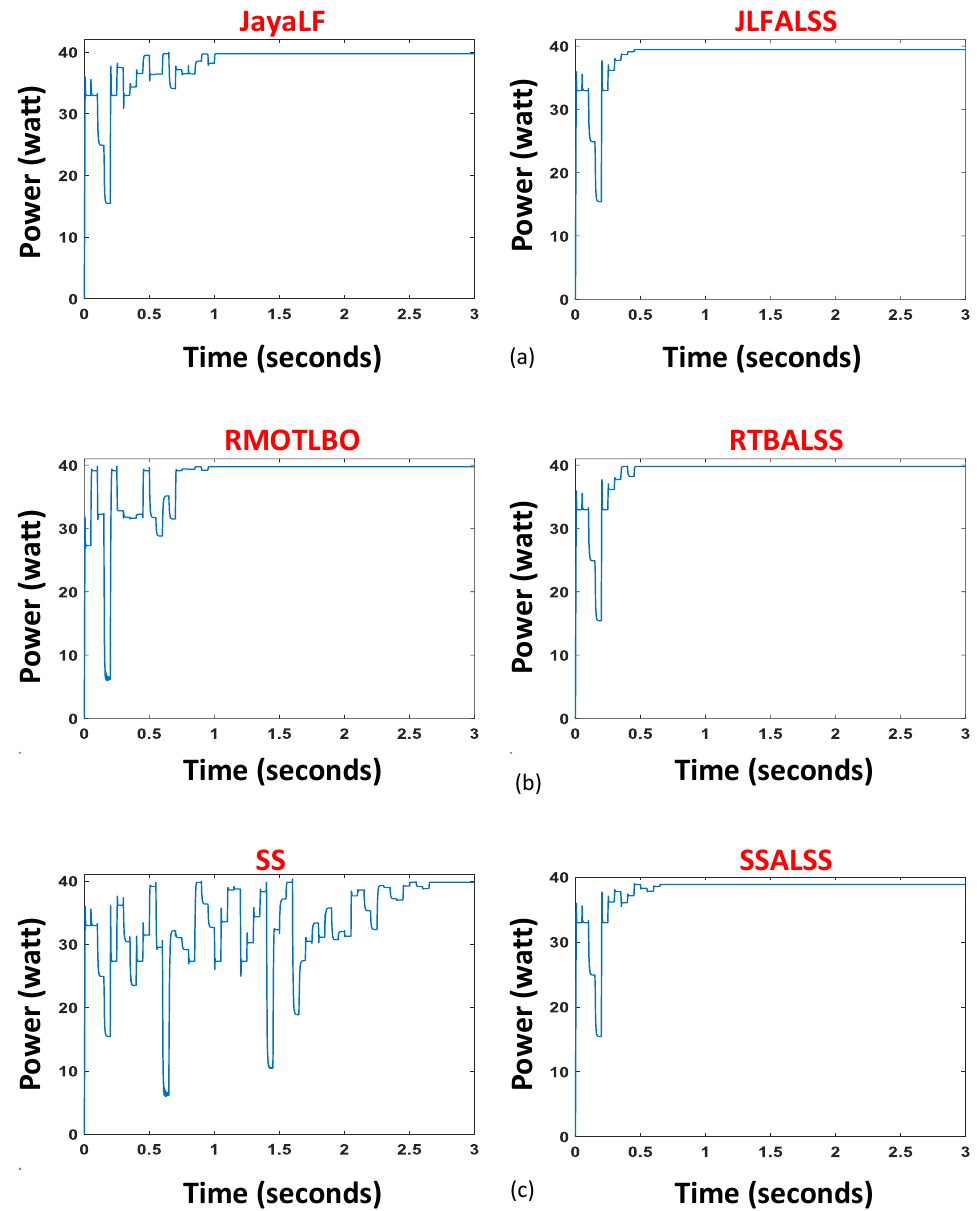
Figure 6. Comparison between ( a ) JayaLF and JLFALSS, ( b ) RMOTLBO and RTBALSS, and ( c ) SS and SSALSS for